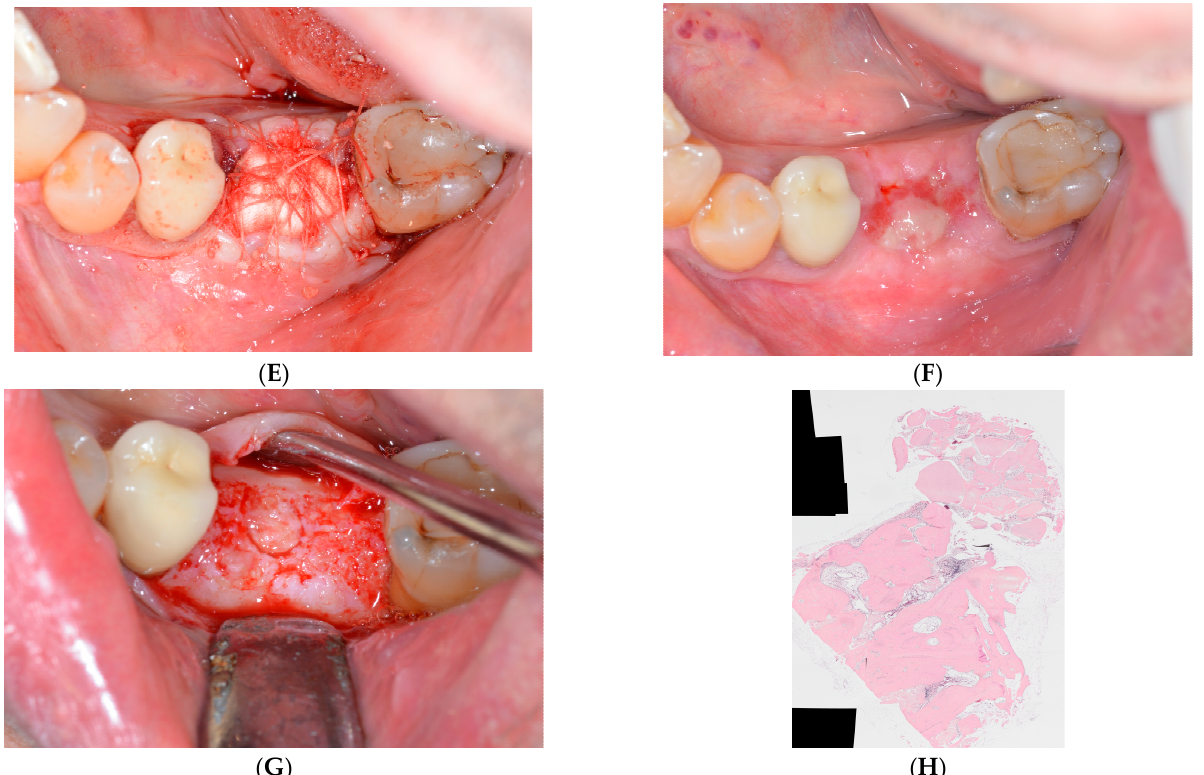
Figure 1. ( A ) Tooth Transformer device. Blade box with the tooth specimen after surgical extraction and before shredding and demineralization treatment. ( B ) Tooth graft materials after shredding and demineralization. ( C ) Autologous tooth-derived graft material placed in alveolar post-extractive socket. ( D ) Three reabsorbable membrane placements to cover the tooth graft materials. ( E ) Suture. ( F ) ASP technique healing period after suture excision. ( G ) Surgical bone biopsy excision after 4-month healing period. ( H ) Bone histological specimens for Group A.